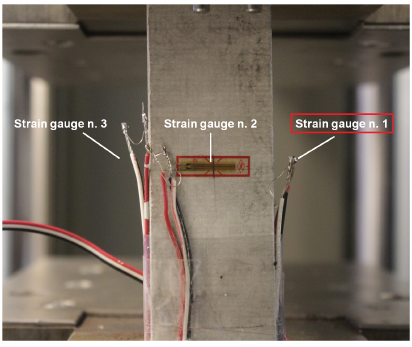
Figure 8: The strain gauges disposition on the 90 ◦ fiber orienta- tion sample.